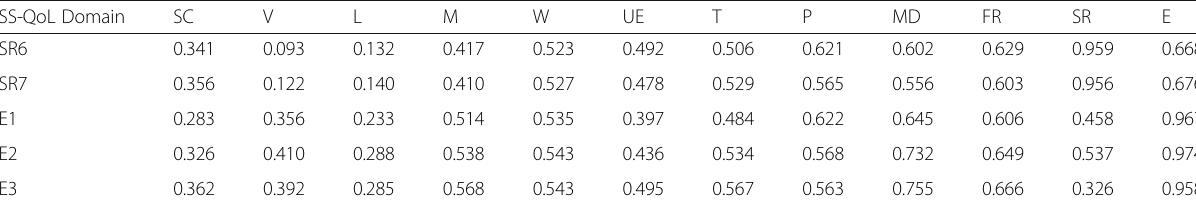
Table 7 Item-domain correlations (discriminant validity) of the Hausa version of the Stroke Specific Quality of Life 2.0 ( n = 86)